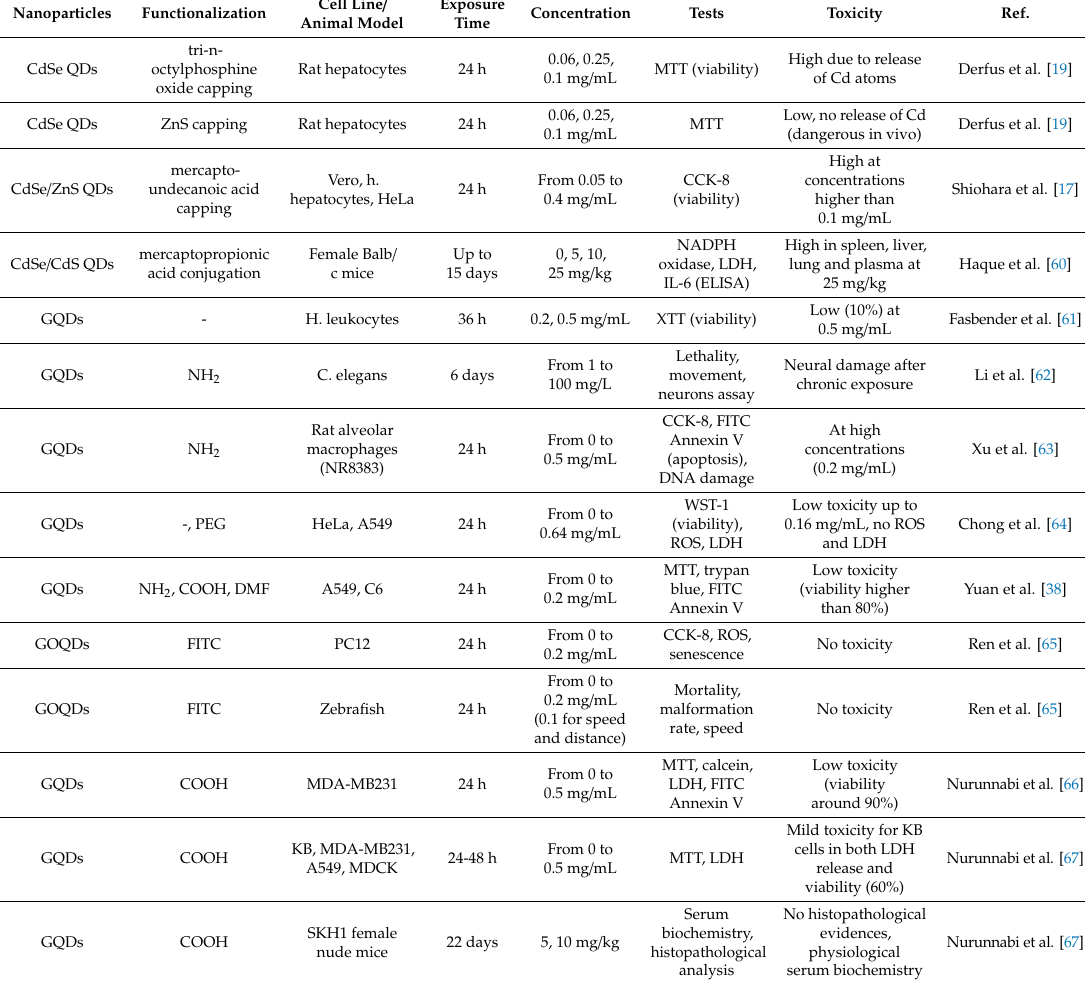
Table 1. Toxicity of graphene quantum dots (GQDs) and quantum dots